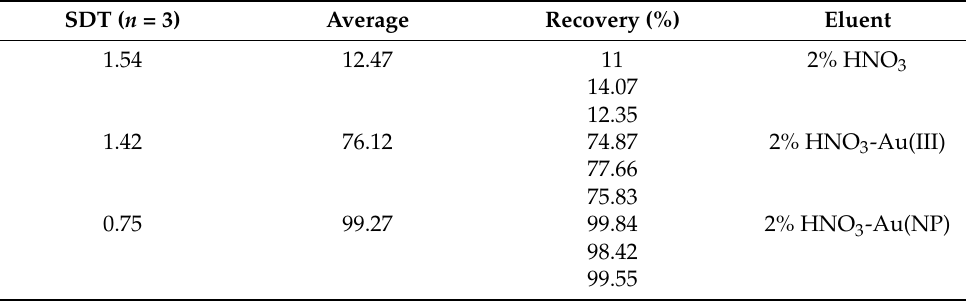
Figure 7. Photo of eluent solutions utilised: Au(NP), Au(III), and 2% HNO 3 . Table 2. Effect of eluent solutions.